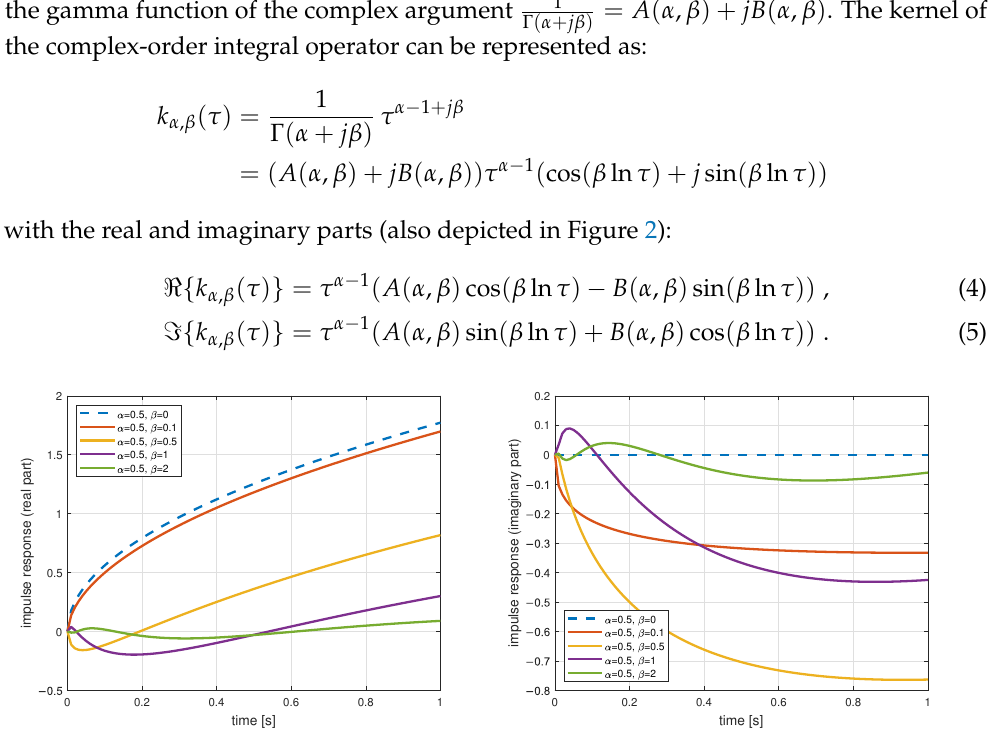
Figure 2. Real ( left ) and imaginary ( right ) parts of the impulse response (kernel) of the complex- order